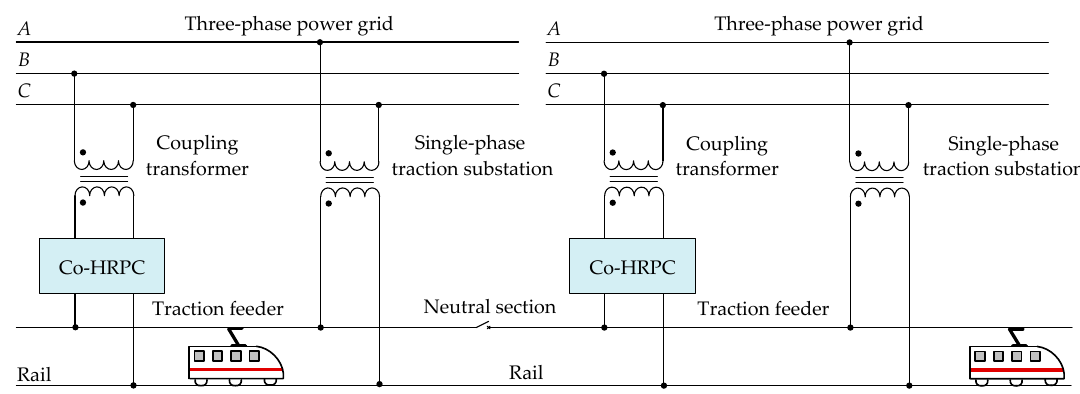
Figure 12. Double-side feeding co-HRPC substations (based on [20]).